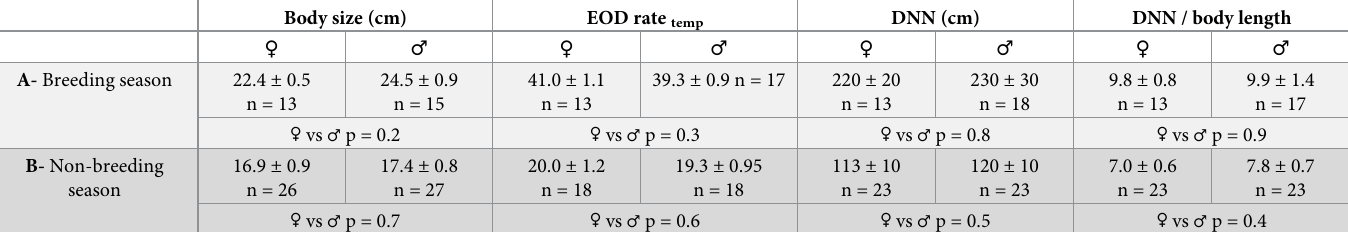
Table 1. Sexual comparison of individual traits and DNN in the breeding season and in the non-breeding season (Survey 2). Individual traits: Body length and EOD rate corrected by water temperature. Distance to the nearest neighbor (DNN in cm), and relative DNN (DNN/body length). Values are expressed as mean ± standard error of the mean (SEM), and statistical comparisons were performed by